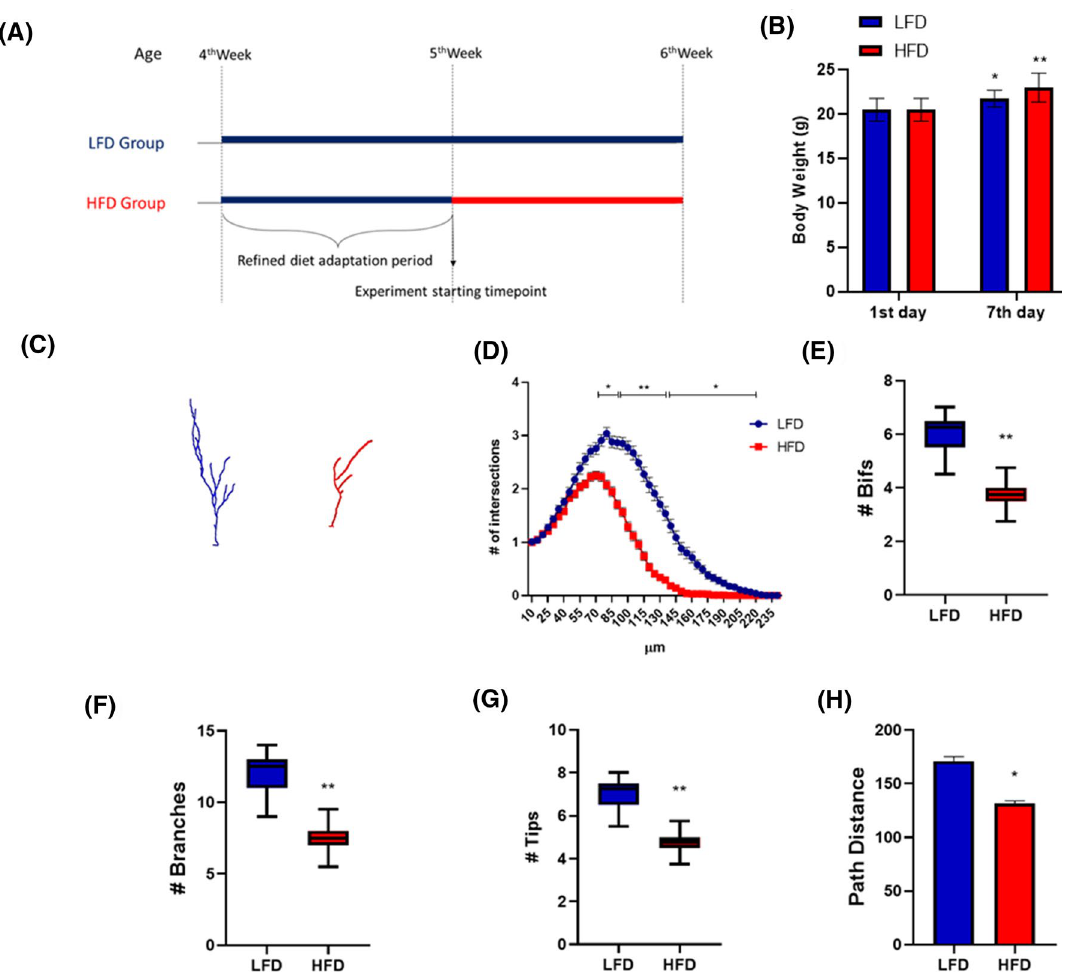
Figure 1. 7-day HFD affects cellular complexity of DCX immunolabeled cells in dorsal hippocampus. Schematic experimental design ( A ). Animal body weight at the beginning of the experiment (1st day of diet, 5 weeks of age) and after 7 days of relative diet ( B ). Data are represented as mean ± SEM. *p < 0.05, **p < 0.01 vs. 1st day corresponding group value. Two-way ANOVA with Tukey’s multiple comparisons test. Representative DCX + cell 3D morphological reconstruction in the dorsal hippocampus of animals fed with a LFD (Blue) or HFD (Red) for 1 week ( C ). Sholl intersections profiles of DCX immunolabeled cells of the dentate gyrus of the dorsal hippocampus of animals fed for 7 days with HFD (Red) or LFD (Blue) starting from the fifth week of age (n = 4 animals per group) ( D ). Data are presented as mean ± SEM. *p < 0.05, **p < 0.01 vs. LFD, nested ANOVA on linear mixed-effect model, with animal as a random effect. Summary of morphometric parameters illustrating the total number of bifurcations ( E ), the total number of branches ( F ), the total number of terminal tips ( G ) and the path distance ( H ) of DCX immunolabeled cells of the dentate gyrus of the dorsal hippocampus of animals fed for 7 days with HFD (Red) or LFD (Blue) starting from the fifth week of age (n = 4 animals per group). Data are represented as Box and Wiskers graph ( E–G ) or bar graph (mean ± SEM) ( H ). *p < 0.05, **p < 0.01 vs. LFD, ANOVA on linear mixed-effect model, with animal as a random effect. ImageJ FIJI software (version 1.52) (https:// imagej. nih. gov/ ij/) was used to produce cell 3D morphological reconstruction. GraphPad Prism 8 (https:// www. graph pad. com/) and Power Point were used to generate the figure.